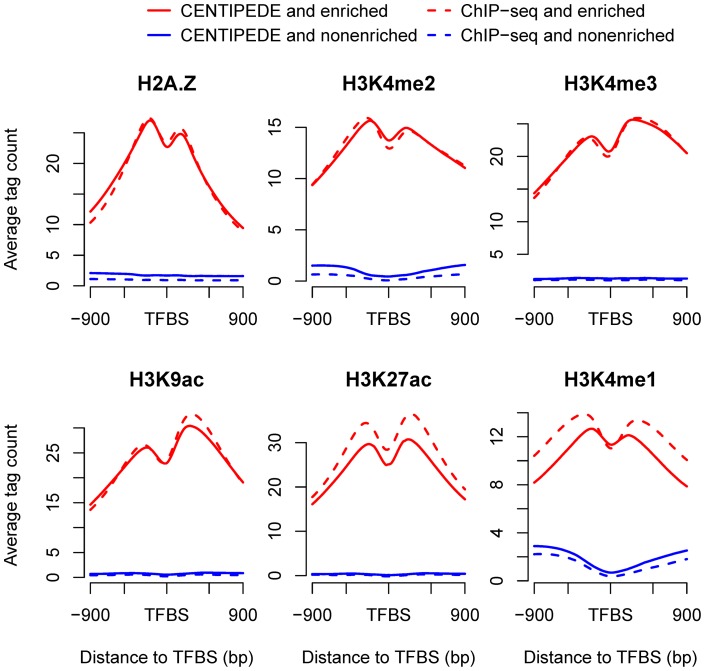
Patterns of six short-range marks around enriched and non-enriched sites by CENTIPEDE and ChIP-seq.The distance between the two local maxima for H3K4me1 was less than 600 bp. Higher H3K4me1 signal intensity around non-enriched sites showed a distinct pattern from other histone marks. Whether a mark was enriched at TFBSs was determined by the tag count in the 600-bp window and the threshold set. Enriched sites were defined as sites with higher tag counts than the threshold.